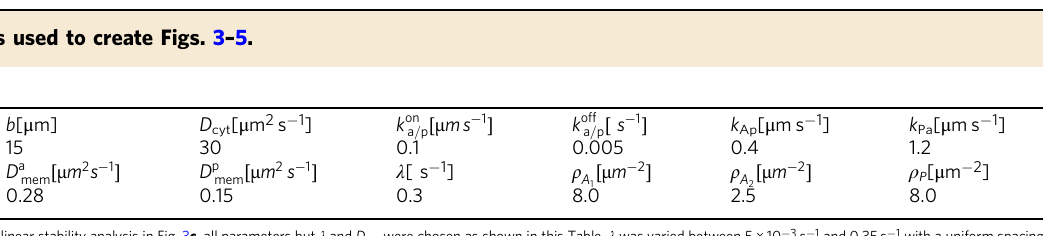
¼ ½ μ m (cid:2) 2 (cid:3) ,while ρ ρ P were , ρ A and ρ P , λ and k Ap weresetasshownabove.Foralltriplesofdensities ρ A A 1 and 1 2 2